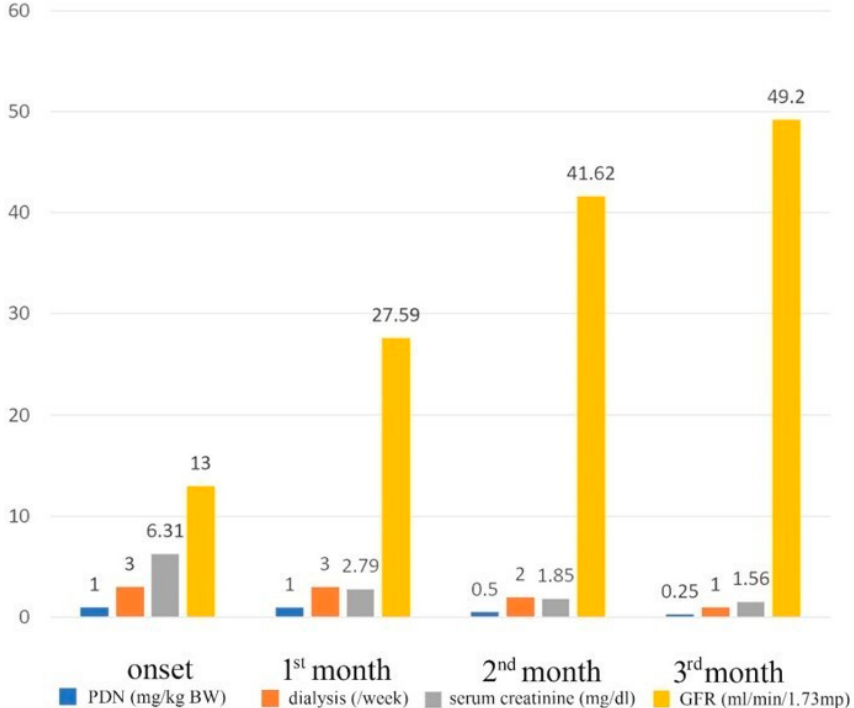
Figure 9. Szekely trichrome staining × 100; renal tissue showing interstitial fibrosis (yellow arrow) (personal collection, St. Mary Emergency Children’s Hospital, Iasi). Disease activity can be followed by angiotensin-converting enzyme (ACE) serum levels. We note an improvement of this parameter 3 months after cortisone therapy as well as an overall improvement of renal function, with dialysis discontinuation and hepatosplenomegaly diminution (Figure 10).